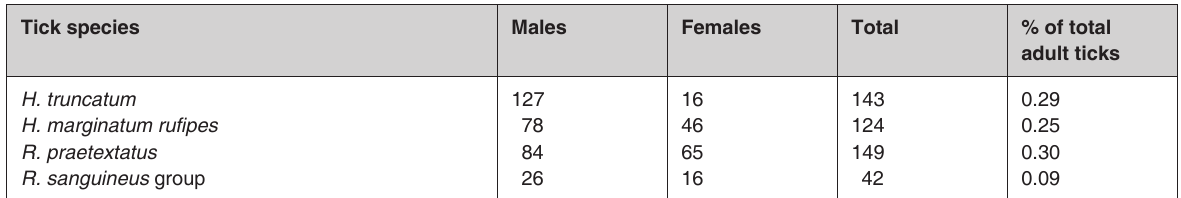
TABLE 3 Total numbers of tick species collected from camels in very low numbers during 2000 and 2001 in River Nile State, Northern Sudan